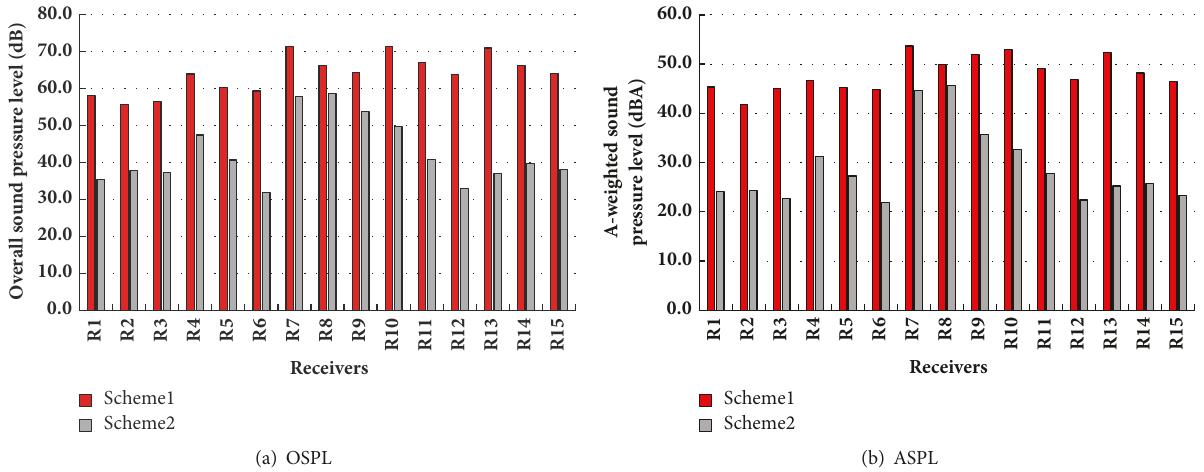
Figure 10: Comparison with sound pressure level of each receiver for the annual average wind speed condition.